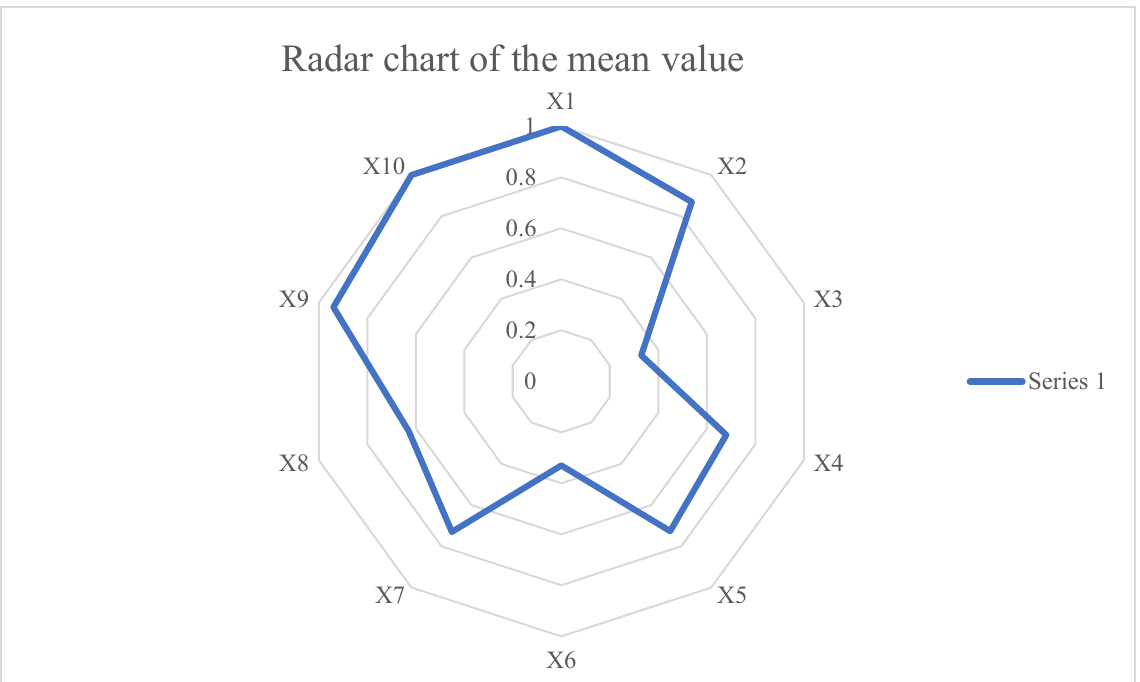
Figure 6. Radar chart of the mean value.